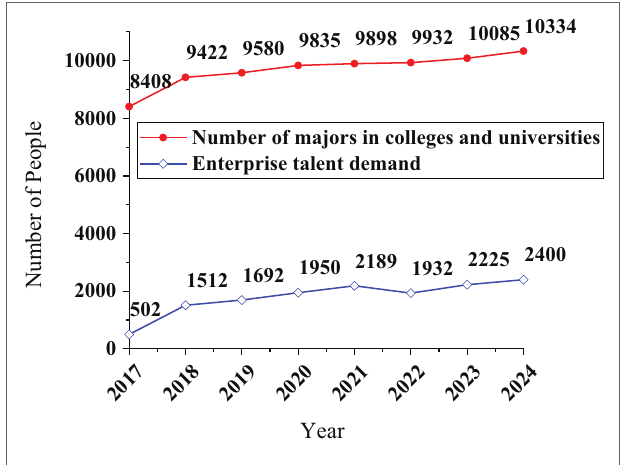
FIGURE 18 | The curve of the number of professional enrollments in colleges and universities and the demand for talents in